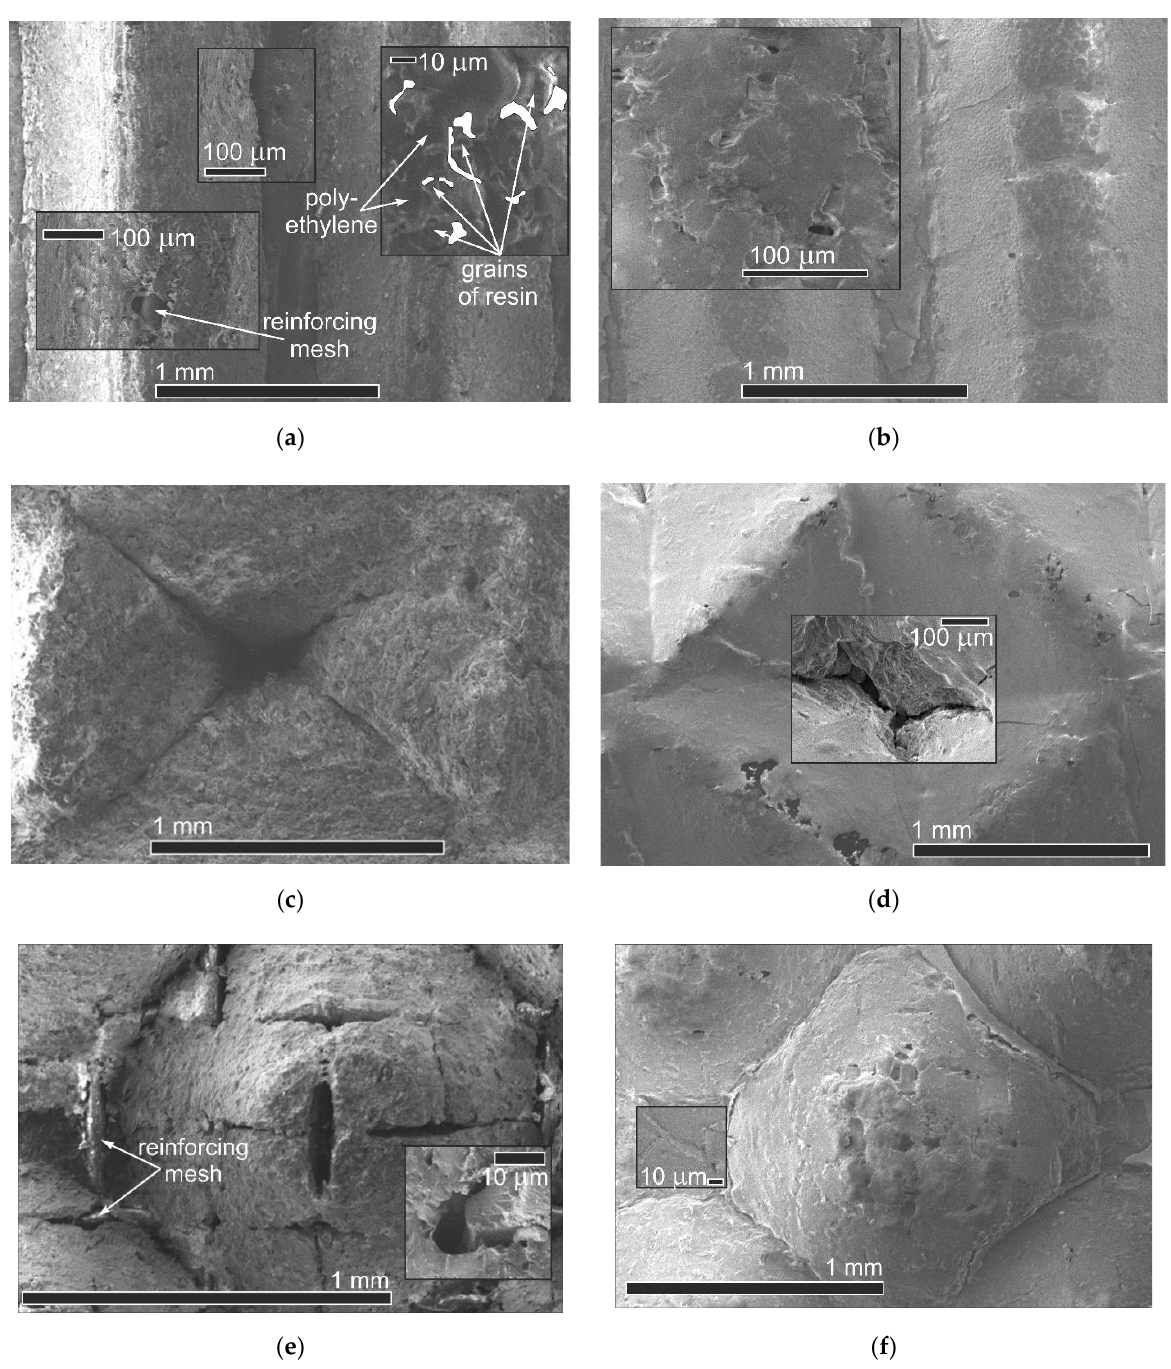
Figure 6. The SEM images of the profiled membrane surface for a single layer ( a , c , e ) and bilayer ( b , d , f ) membranes: a, b: No 1; c, d: No 2; e, f: No 3.